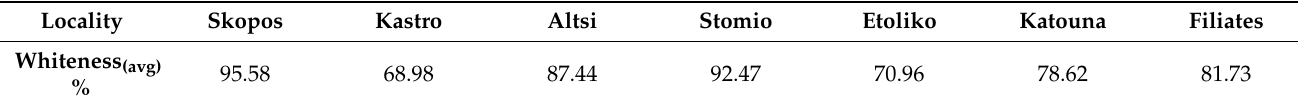
Table 2. Average whiteness rates (%) of the evaporite